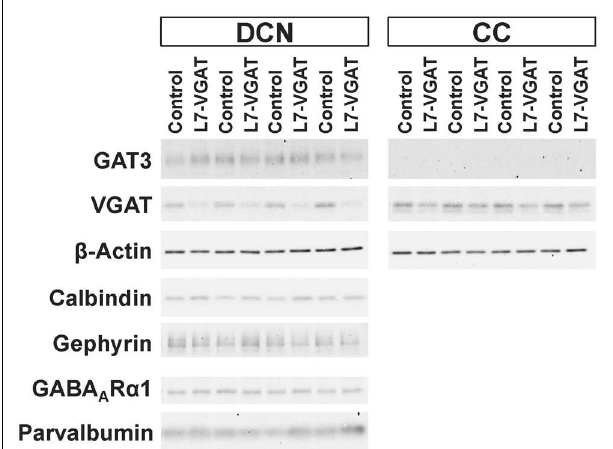
FIGURE 4 | Significant reduction inVGAT protein and unaltered levels of other pre- and postsynaptic proteins in the L7-VGAT DCN. Western blot analyses of GAT3, β -actin, calbindin, gephyrin, GABA A R α 1, and parvalbumin proteins in the crude fractions from control and L7-VGAT DCN and cerebellar cortices at P40W. DCN, deep cerebellar nuclei; and CC, cerebellar cortex. Table 1 | Relative signal intensities of protein immunoreactiveties. DCN CC FIGURE 5 | Roughly maintained-structure of the L7-VGAT cerebellum. Cresyl violet staining of sagittal (A–D) and coronal (E,F) sections of the L7-VGAT L7-VGAT whole cerebellum (A,B) , cerebellar cortex (C,D) , and DCN (E,F) of 40-week-old control (A,C,E) and L7-VGAT (B,D,F) mice. Areas surrounded by black rectangles in (A) and (B) are shown in (C) and (D) , respectively. Scale bars represent 500 μ m (A,E) and 50 μ m (C) . Dcn, deep cerebellar nucleus; Gra, granule cell layer; Pur, Purkinje cell layer; and Mol, molecular layer.